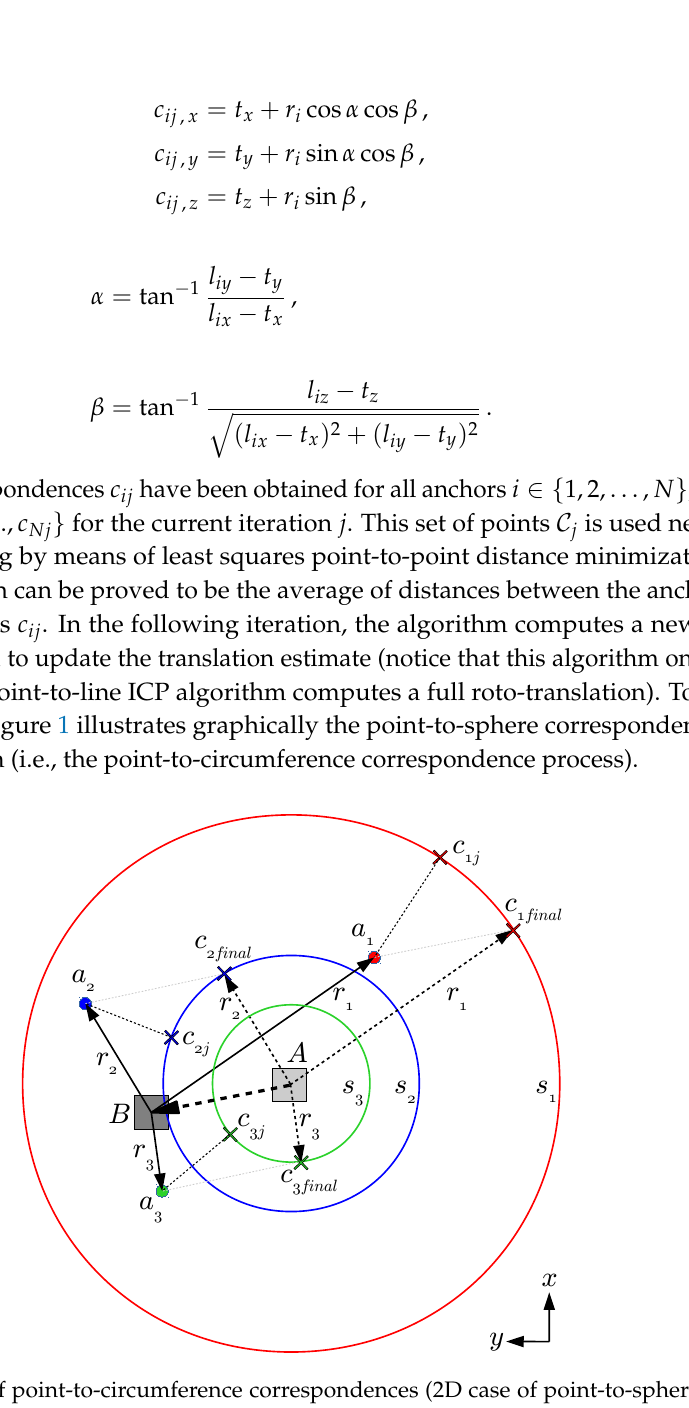
Figure 1. Example of point-to-circumference correspondences (2D case of point-to-sphere Iterative Closest Point (ICP)). The tag moves from point A to point B , while the anchors a 1 , a 2 and a 3 are static. c 1 j , c 2 j and c 3 j are the points over the three circumferences which are closer to the corresponding anchor in the current iteration j . c 1,final , c 2,final and c 3,final are the final correspondences after ICP